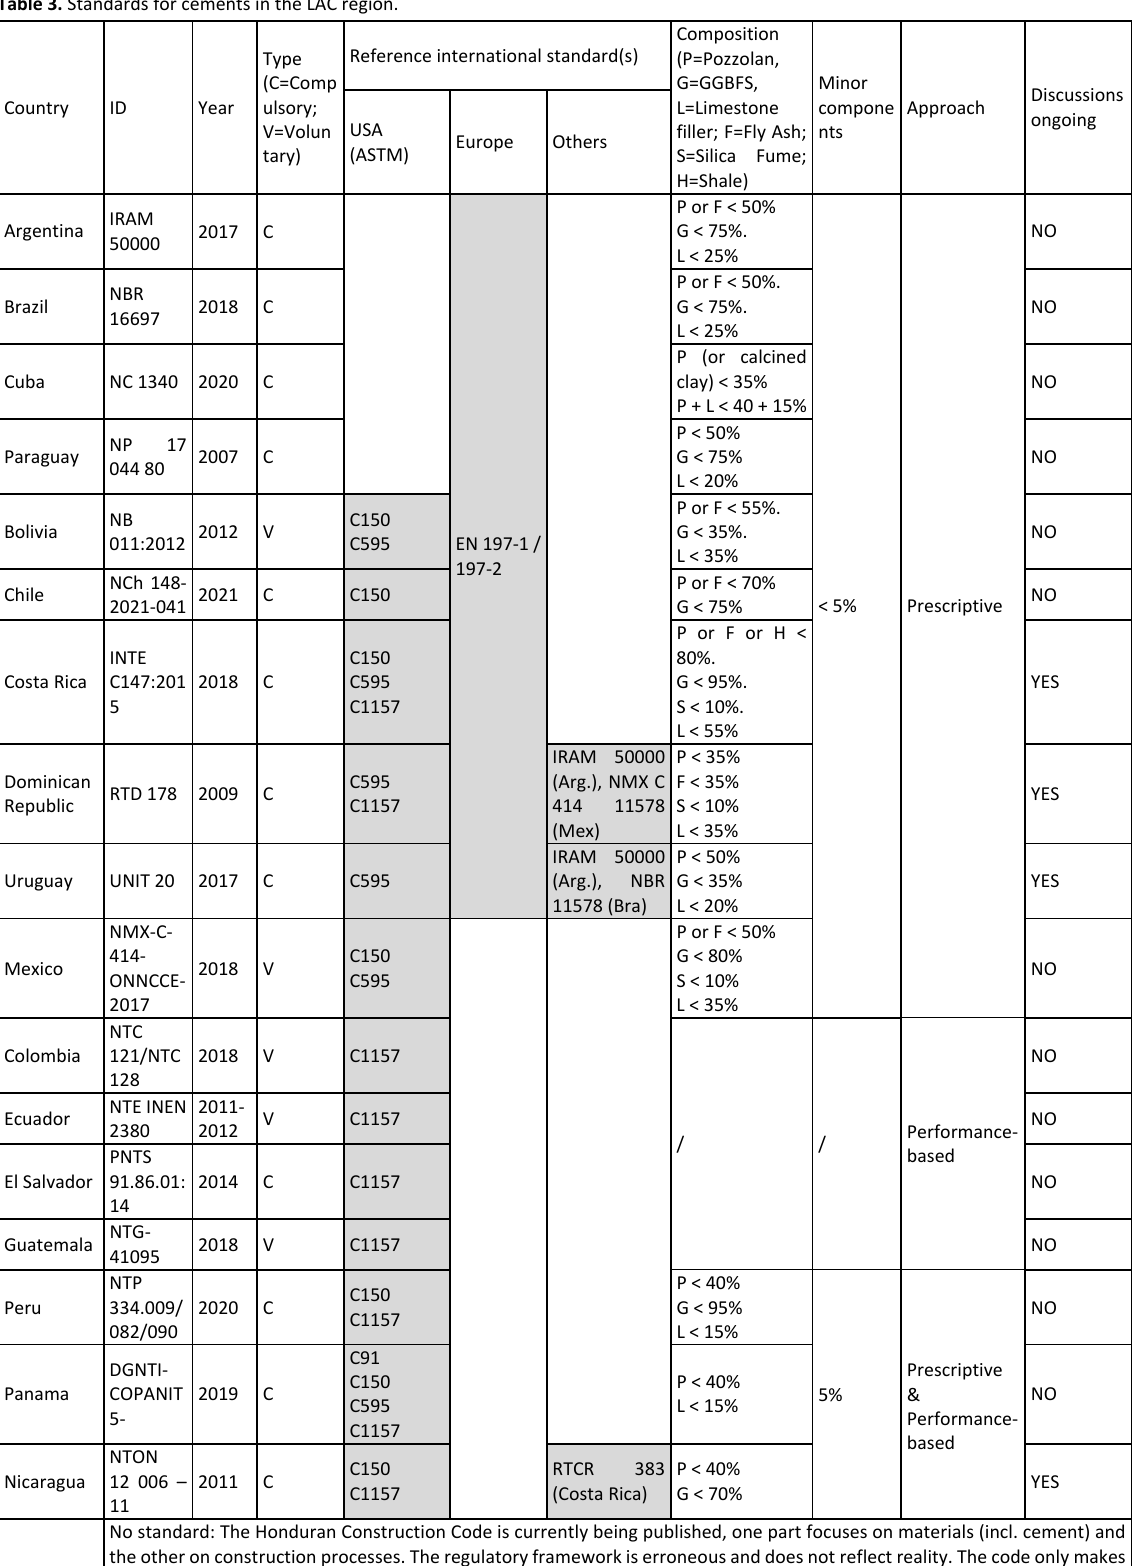
Table 3. Standards for cements in the LAC